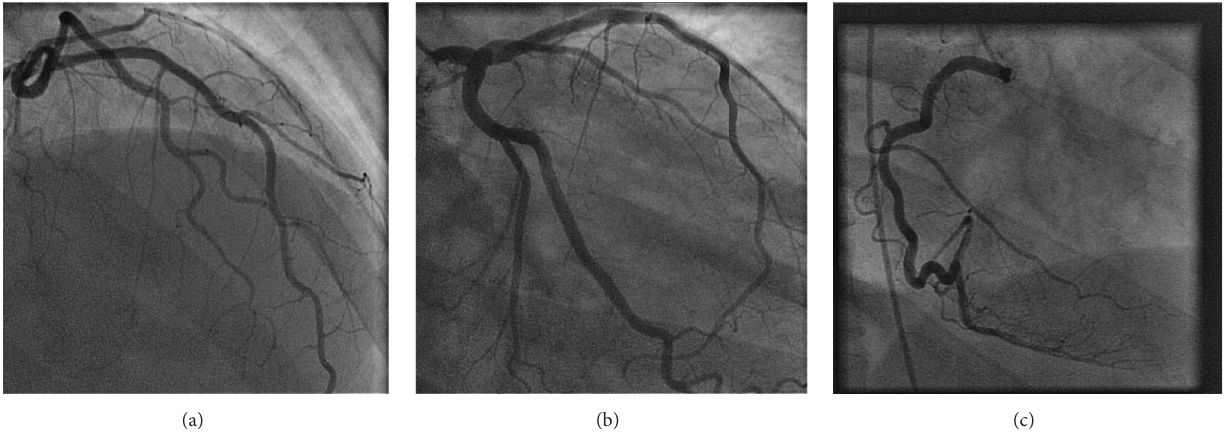
Figure 3: Coronary catheter angiogram revealing normal coronary vessels. Left circumflex artery (a), left main artery (b), and right main coronary artery (c) are